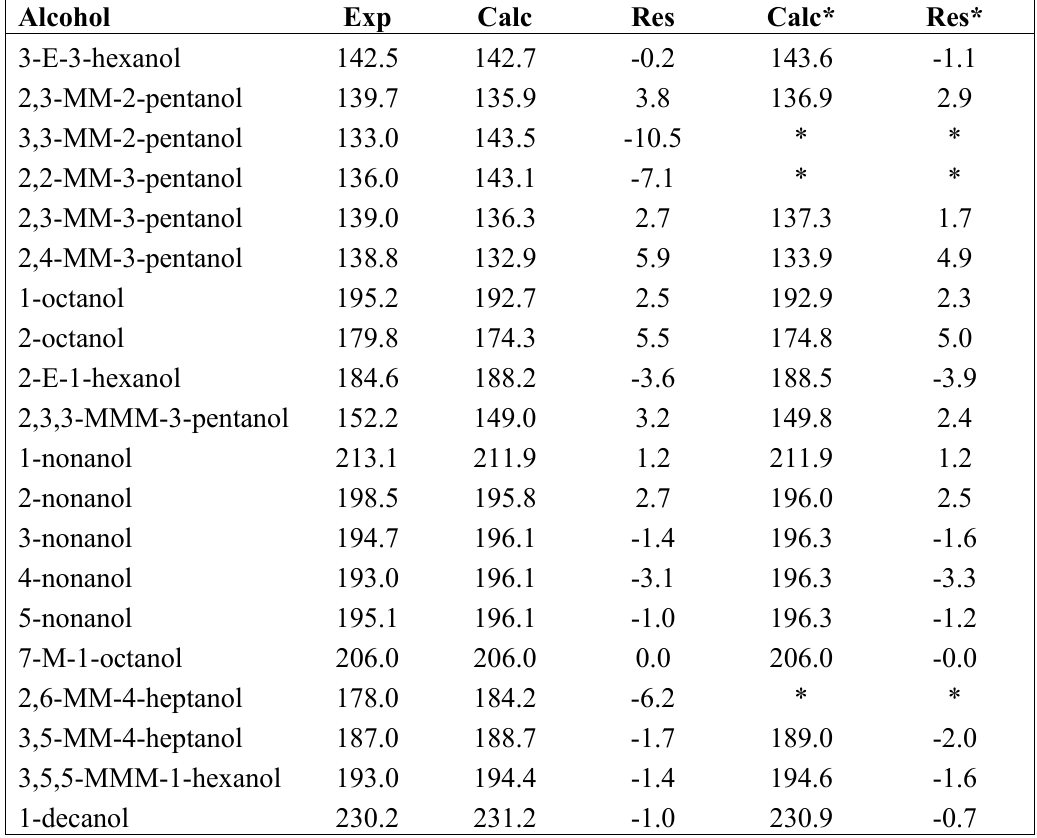
In Fig. 1 we have plotted the calculated normal boiling points against the experimental normal boiling points. Figure 1. Calculated normal boiling points plotted against the experimental normal boiling points for 58 alcohols